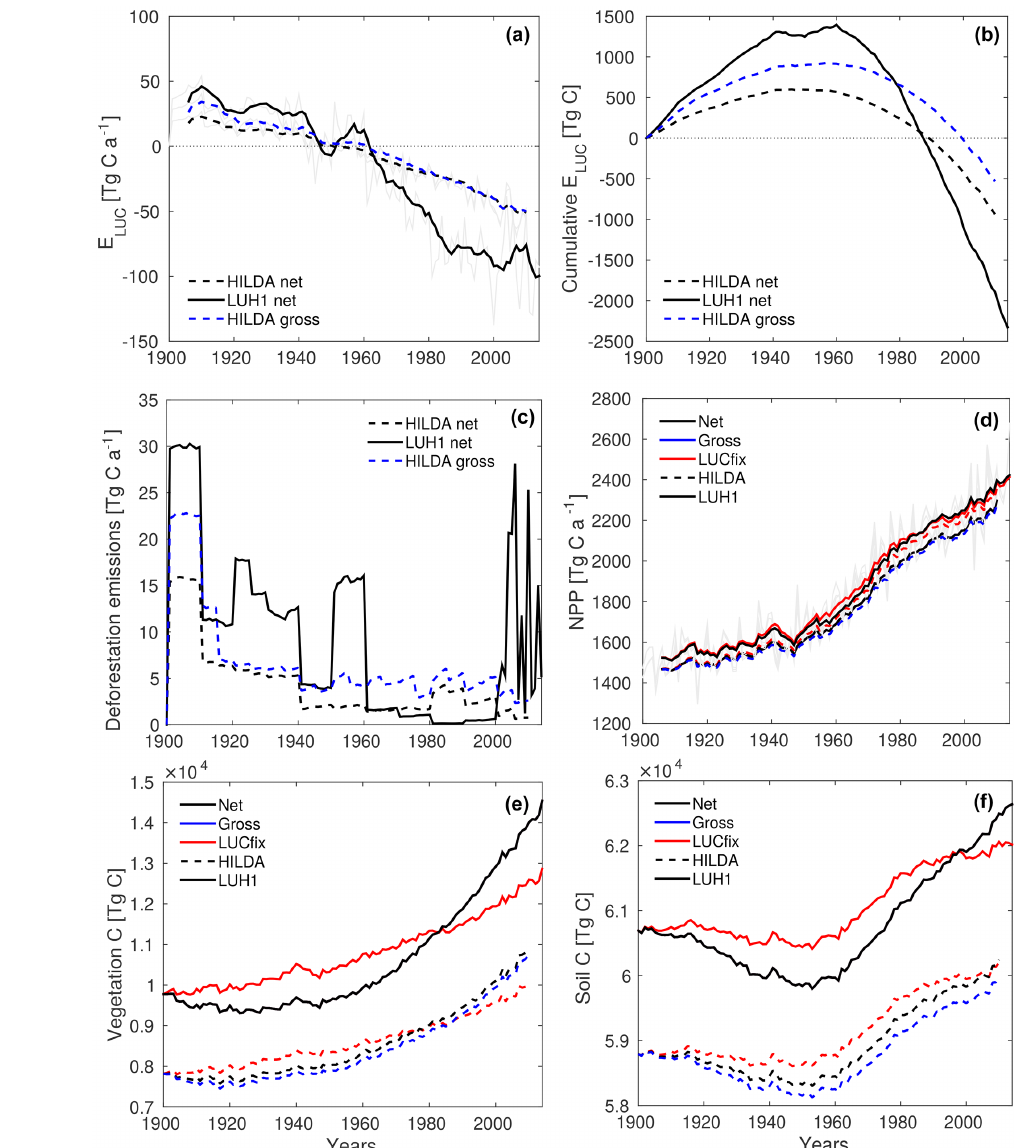
Figure 3. Effects of different land-use representations on ecosystem C stocks and fluxes for Europe (EU27 + CH): land-use flux (a) , cu- mulative land-use flux (b) , deforestation emissions (c) , net primary productivity (NPP) (d) , vegetation (e) and soil C (f) . Flux values in (a) and (d) are given as 15-year averages with original values in the background. NPP, vegetation and soil C is shown for simulations experiencing net (or gross) LUC and in addition for simulations where LUC was kept at 1700 levels (see the “Methods” section; red lines in d, e, f